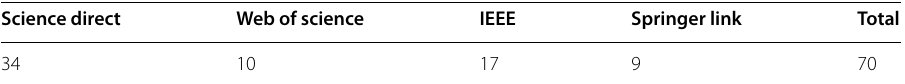
Table 7 Literature extraction and synthesis process stage Science